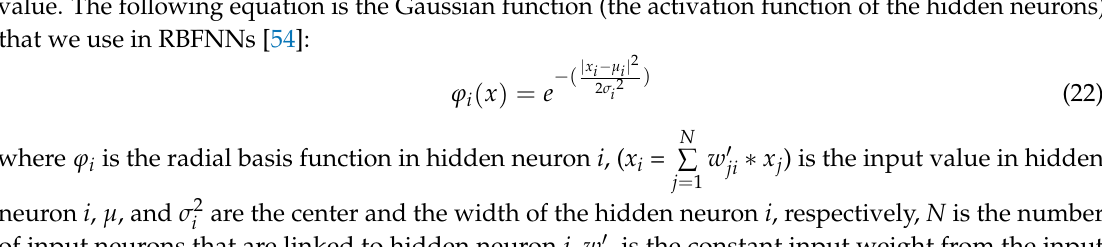
Figure 5. Structure of a radial basis function neural network.